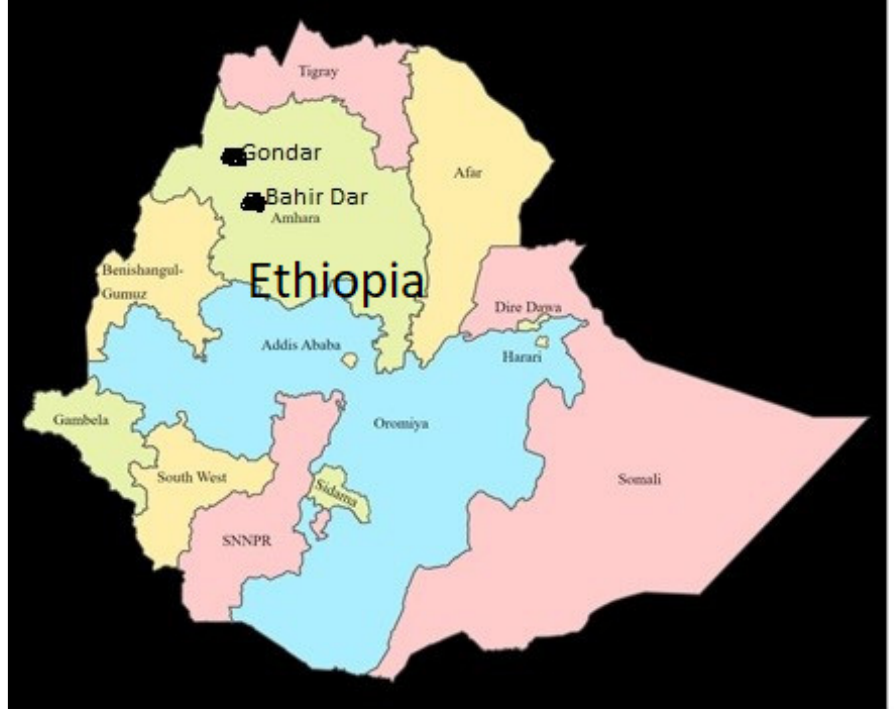
Figure 1. Location map of study areas.(Source: Google map)